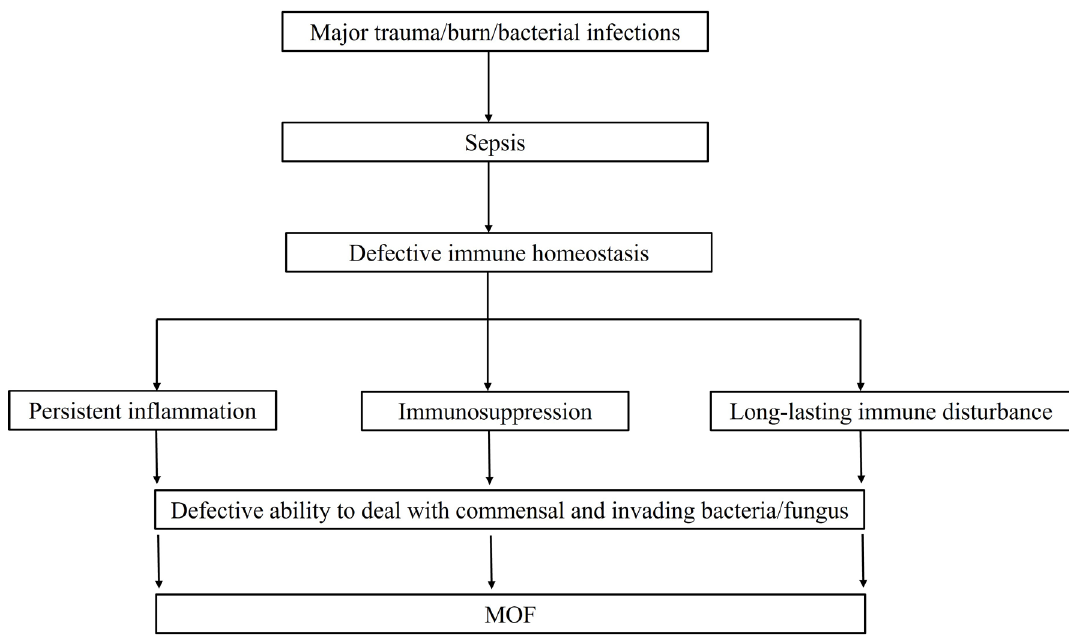
Figure 1. How sepsis leads to the defective functions of immune system and subsequently causing the MOF Immune suppressive players of sepsis